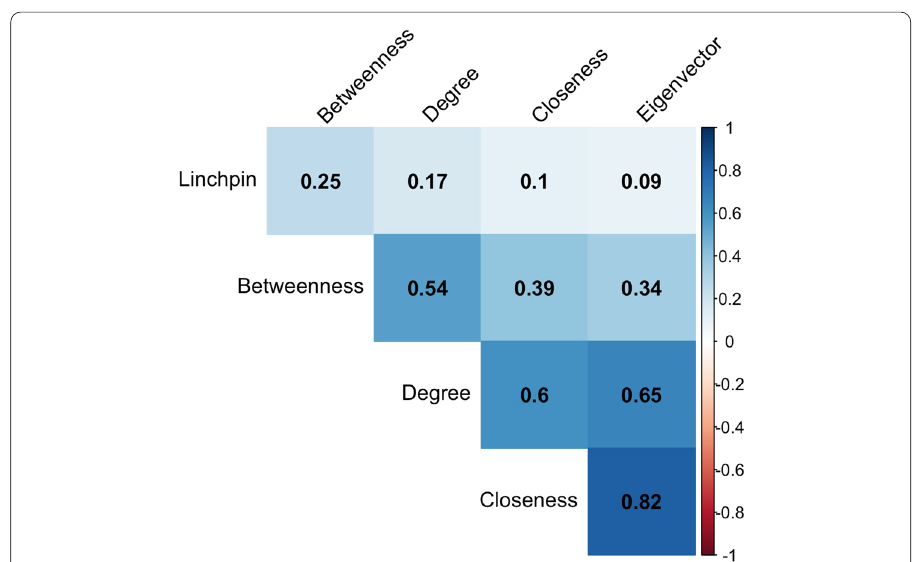
Fig. 3 Heatmap of the correlation matrix of linchpin, degree, betweenness, closeness, and eigenvector centrality for the physician network. Correlation was measured using Kendal’s Tau non-parametric correlation